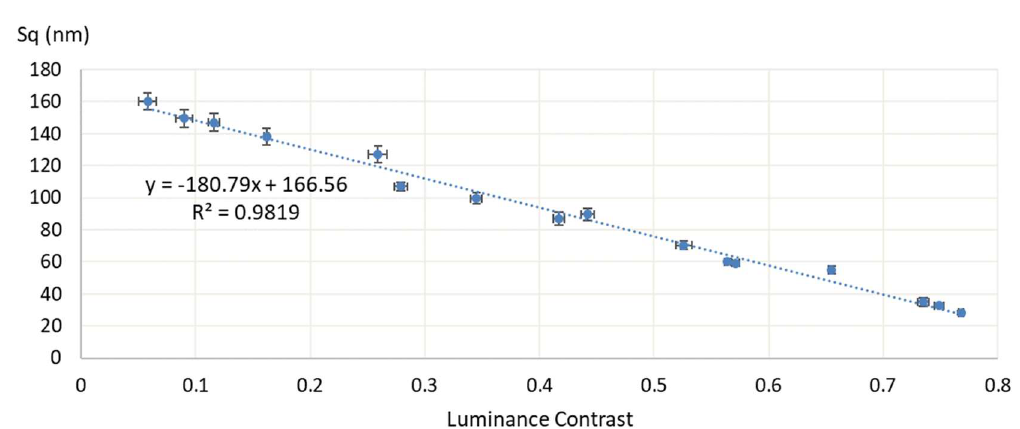
Figure 11. Sq -contrast curve.